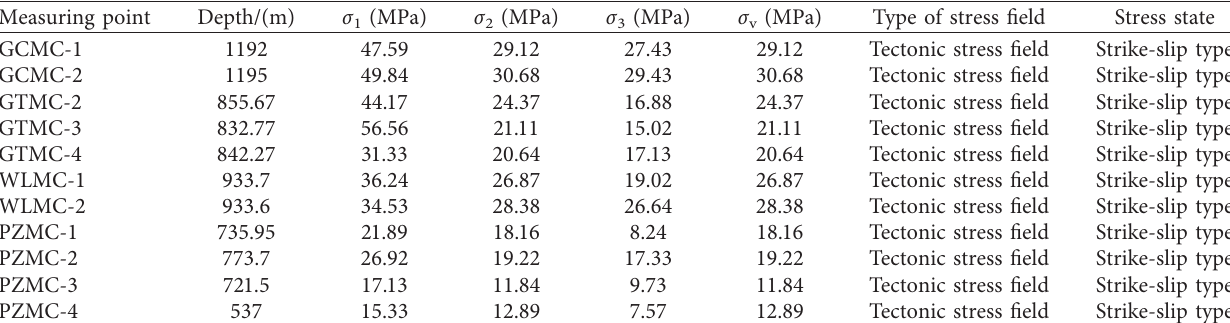
Table 2: Stress situation of each mining area.